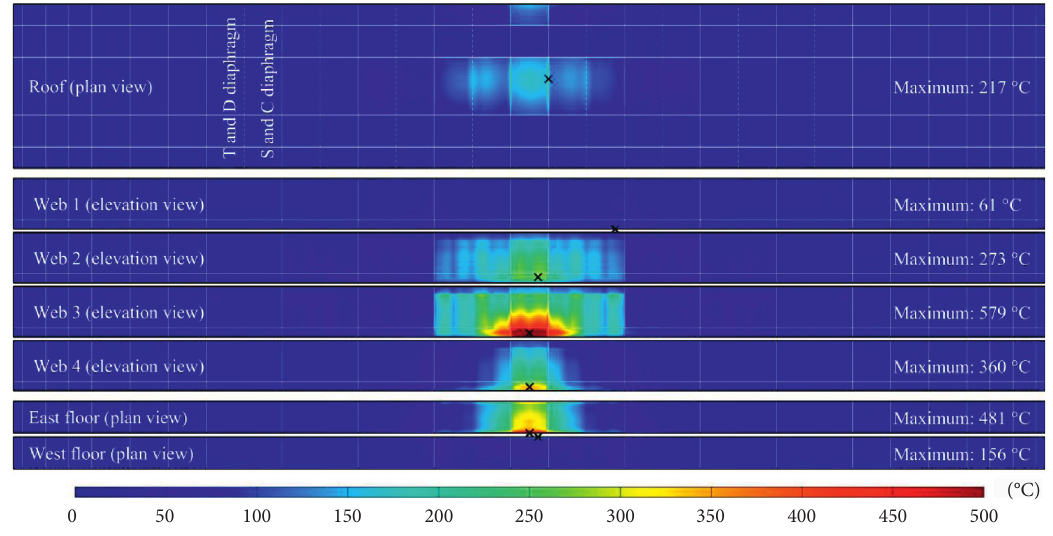
Figure 8: Isotherm of main plates at